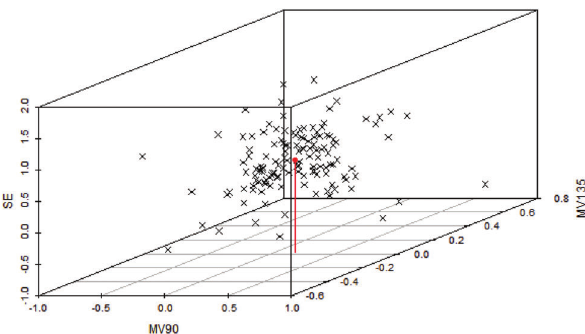
Figure 2 - Trivariate analysis showing the influence of the parameters spherical equivalent, magnitude vector 90 and magnitude vector 135 on differences between right-eye refrac- tion values obtained under cycloplegia by Spot Vision Screen- ing TM and by subjective clinical refractometry) in a sample of 134 healthy Brazilian volunteers. SE: spherical equivalent; MV 90: magnitude vector on the 90 o axis, magnitude vector 135: difference between diopter components projected on the 135 o axis and the 45 o